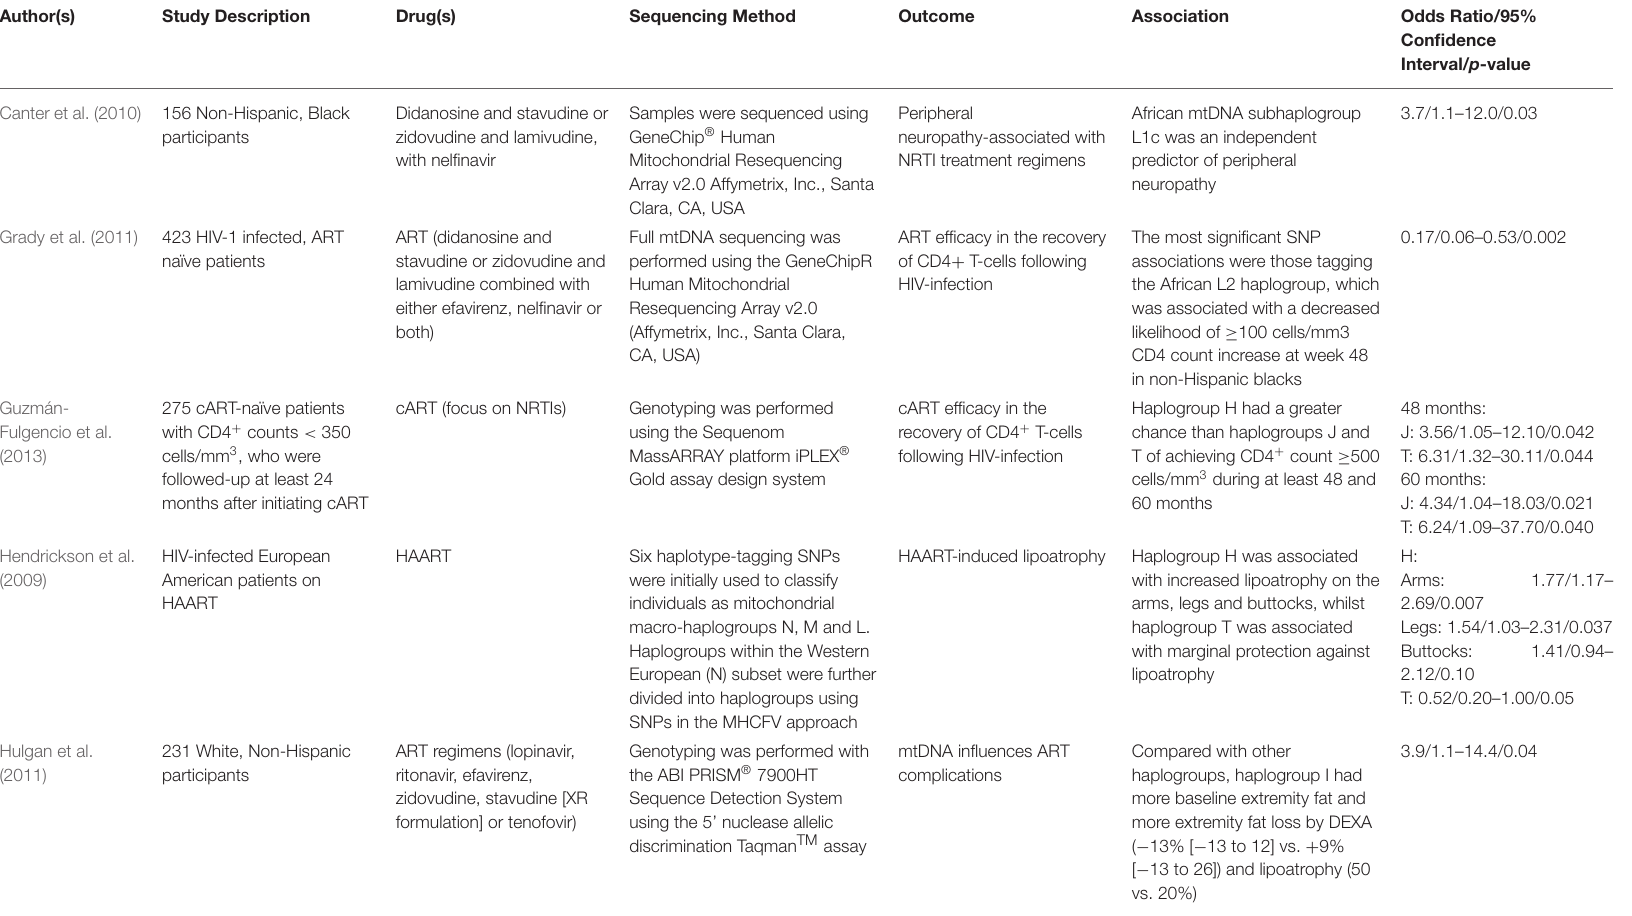
TABLE 4 | Summary of the publications included in this review that report differential responses to antiretroviral